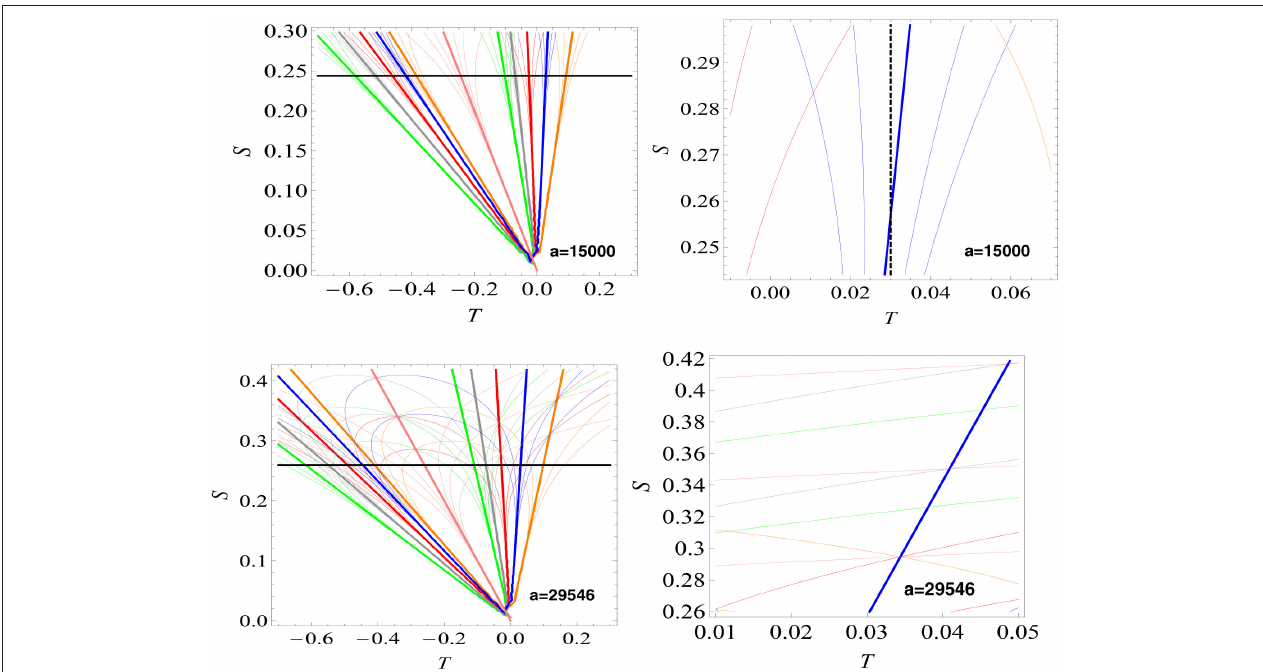
FIGURE 1 | The web structure of resonances in the space of the actions for a = 15 , 000 km (upper panels) and a = 29 , 546 km (bottom panels). The thick curves represent the location of the following exact resonances (the multiplet component having s I ω (cid:127) 133.6 ◦ ), 2 0 (gray color, I = ˙ − ˙ = color, I 46.4 ◦ , I 106.9 ◦ ). The thin curves give the position of the resonances (2 = = dashed line (top right panel) corresponds to the values of T used in computing the Figure 6 . Left panels are obtained for S varies from S min to S max , as explained in the